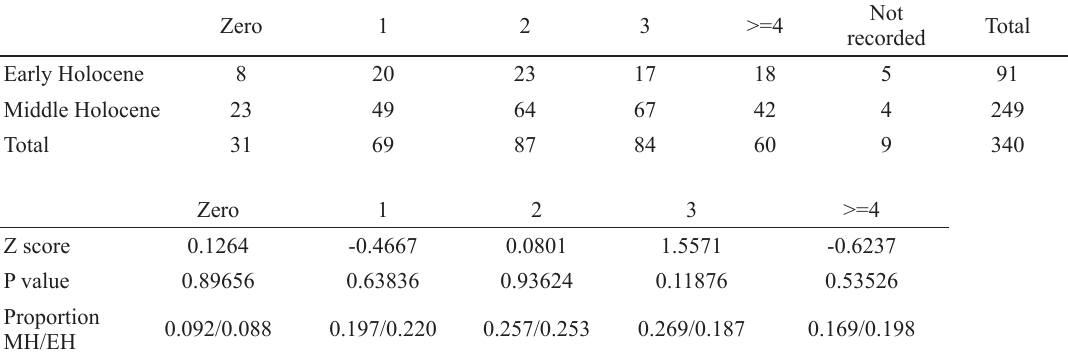
Number of dorsal scars, Z-test results (z score and p value) and proportion between Middle Holocene (MH) and Early Holocene (EH)